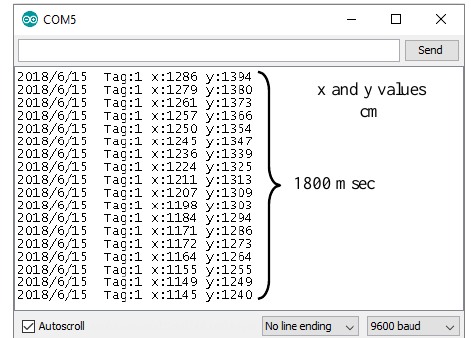
Figure 7. Tag location values in x and y